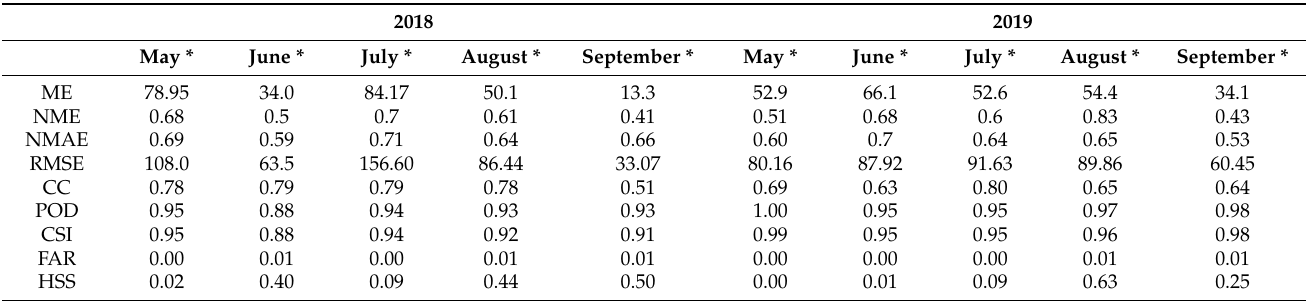
Table 3. Evaluation results of monthly rainfall accumulations (CONUS-west *).